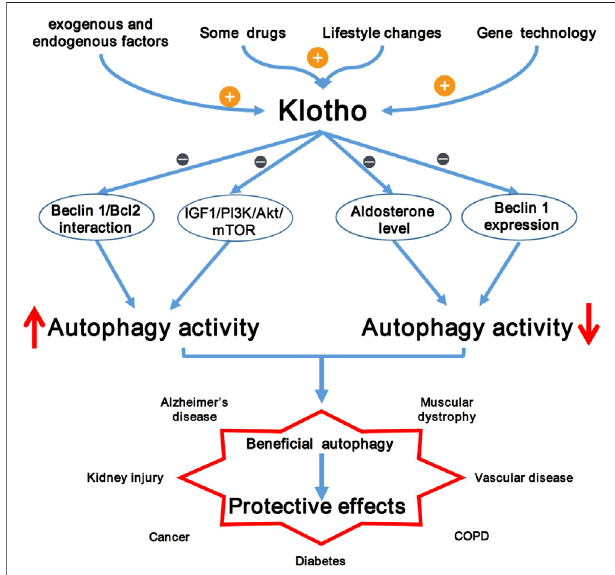
FIGURE 1 | Klotho as potential autophagy regulator and therapeutic target. The expression of Klotho can be upregulated by many exogenous and endogenous factors, some drugs, lifestyle changes and gene technology. Klotho plays a dual role in regulating autophagy (induction or inhibition) through its in fl uence on the IGF-1/PI3K/AKT/mTOR signaling pathway, Beclin 1 expression and activity, and aldosterone level. Klotho exhibits protective effects in many diseases, making it a potential therapeutic